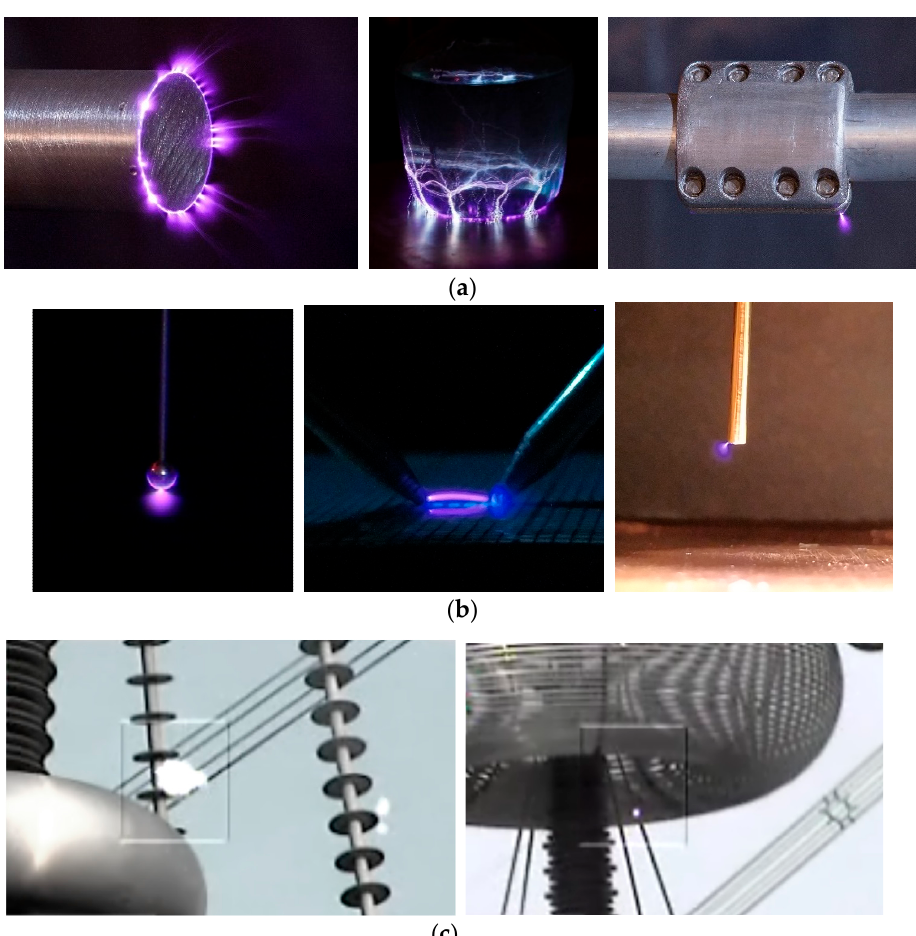
Figure 8. Corona photographs captured with different sensors. ( a ) UV-visible corona photographs captured with a Canon EOS-70D DSLR camera. ( b ) Corona photographs captured with a Sony IMX586 smartphone camera. ( c ) Daylight corona photographs captured with a solar-blind dual- spectra Daycor Superb camera.